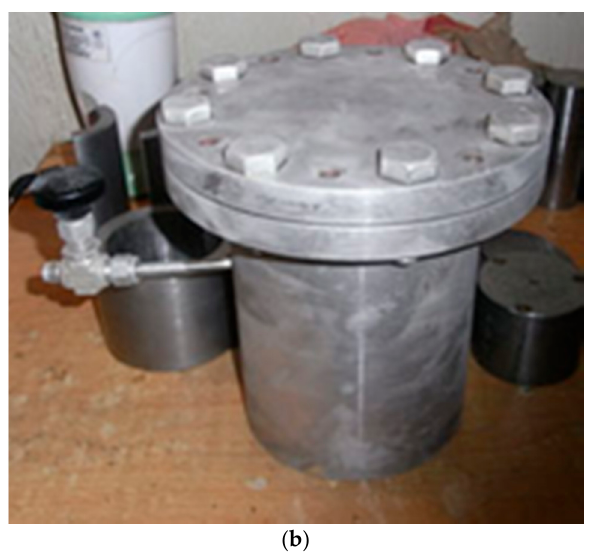
Figure 3. Appearance of the pressure crystal device and the high pressure reaction vessel. ( a ) Pressure crystal device; ( b ) High pressure reaction vessel.